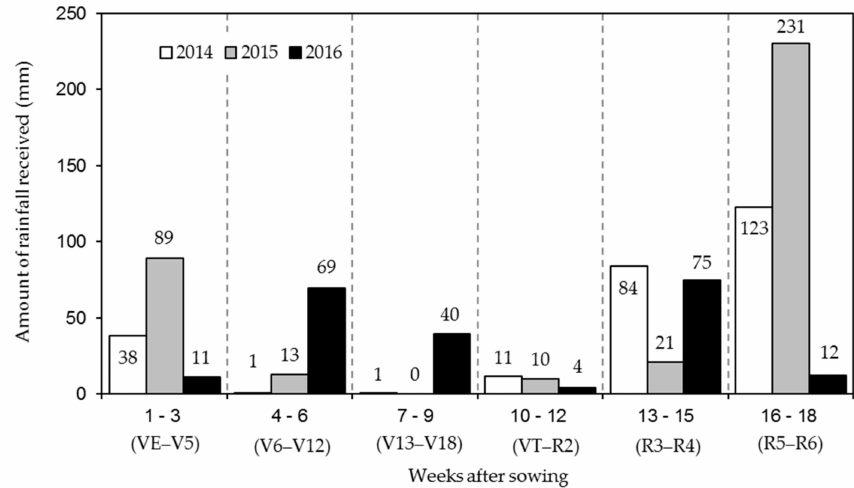
Figure 1. Amount of rainfall received (three-week intervals) in the years 2014, 2015, and 2016 during the trials. Insets are the corresponding growth stages of maize as described by [19]. Correspondingly, maize-plant development is divided into vegetative (V) and reproductive (R) stages. Subdivisions of the V stages are designated numerically as V1, V2, V3, etc. through V(n), where (n) represents the last leaf stage before VT for the variety under consideration. The first and last V stages are designated as VE (emergence) and VT (tasseling).